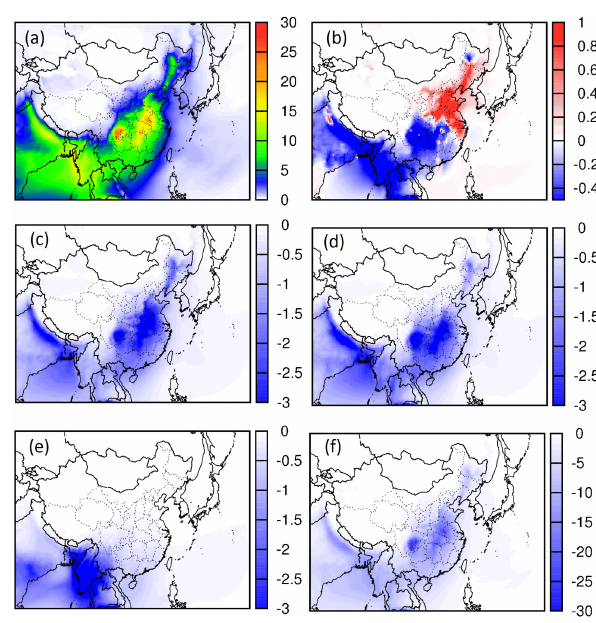
Figure 9. Predicted (a) spatial distribution of SOA for August 2013 and change of SOA concentrations (sensitivity case – base case) due to (b) reduction of anthropogenic NO x by 50%, (c) reduction of anthropogenic VOC by 25%, (d) simultaneous reduction of anthro- pogenic NO x and VOC by 50 and 25%, (e) reduction of biogenic isoprene by 50%, and (f) reduction of all anthropogenic emissions.